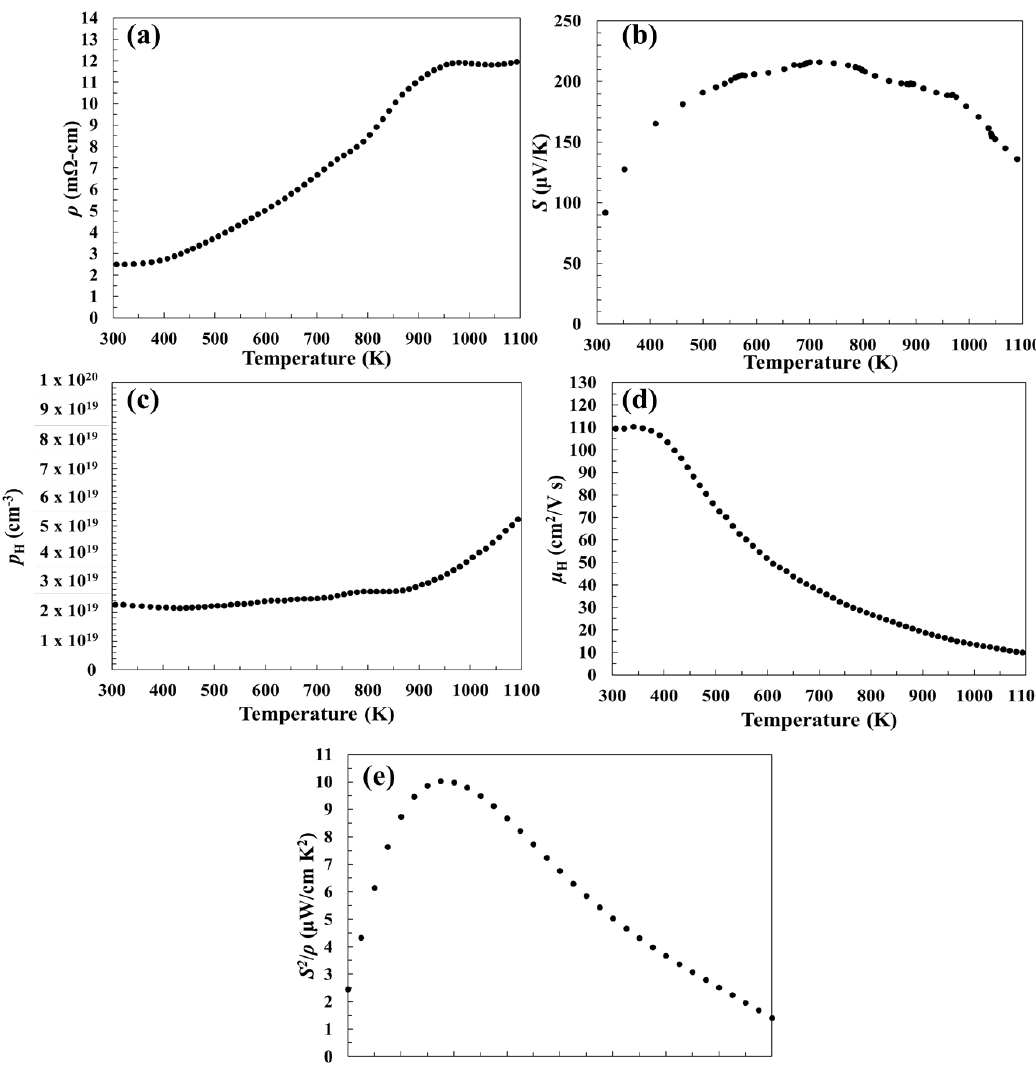
Figure 2. Temperature-dependent ( a ) electrical resistivity, ( b ) Seebeck coefficient, ( c ) Hall carrier concentration, ( d ) Hall mobility, and ( e ) power factor of Sc 2 Te 3 .